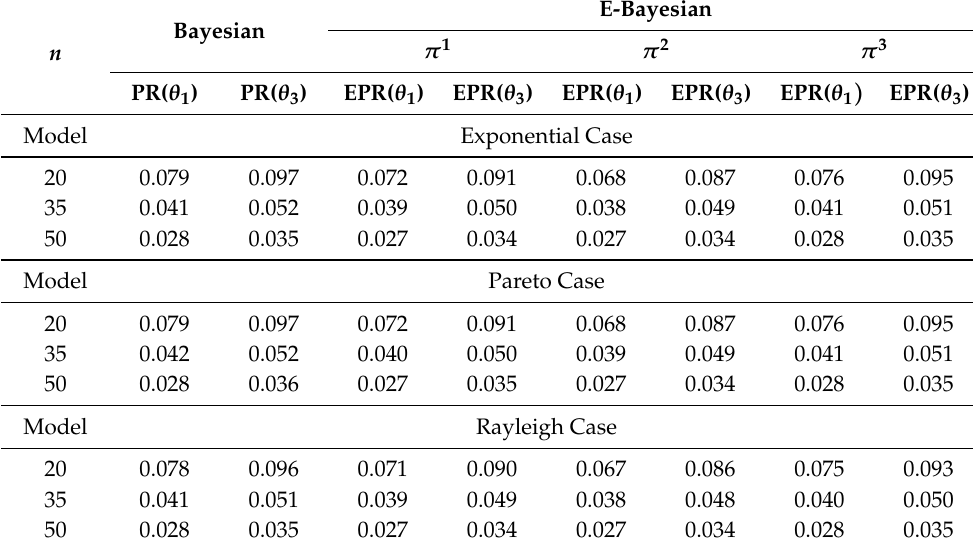
Table 5. The PR and EPR of Bayes estimates for ( θ 1 , θ 3 ) with ( c 1 , c 2 , c 3 ) = ( 1.5,2,1.2 ) .